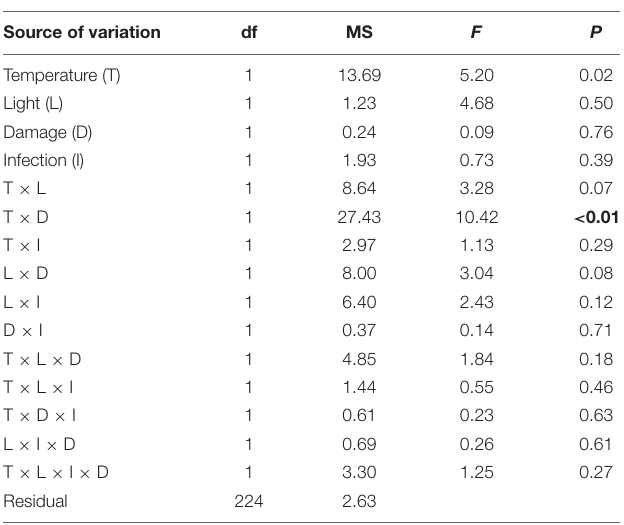
TABLE 4 | Analysis of variance of inhibition of Labyrinthula zosterae growth by extracts of Zostera marina (% relative to controls) from shoots grown under different levels and combinations of temperature (ambient and increased), light (reduced and ambient), tissue damage (damaged and undamaged), and L. zosterae infection (non-inoculated and inoculated).